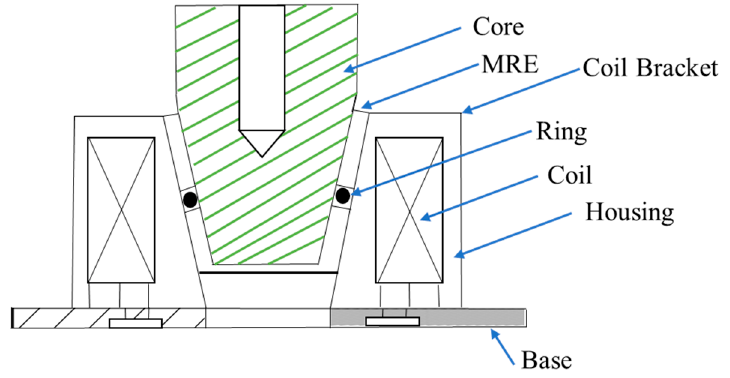
Figure 10. MR elastomer (MRE) seat isolator [81].